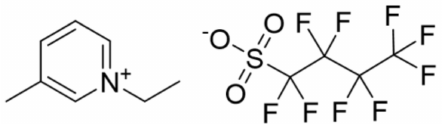
Figure 1. Structure of 1-ethyl-3-methylpyridinium perfluorobutanesulfonate ([C 2 C 1 py][C 4 F 9 SO 3